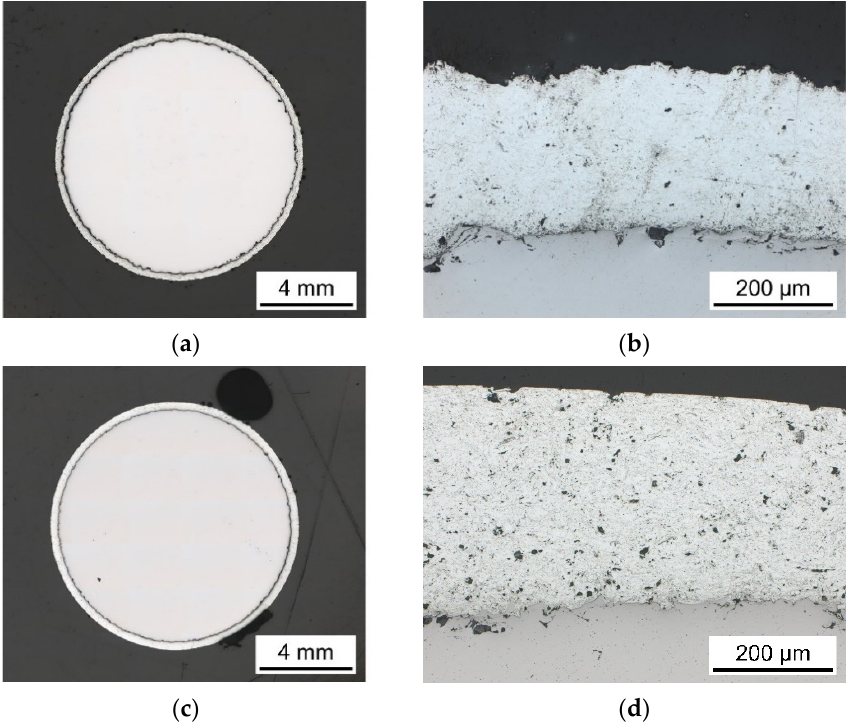
Figure 8. Images of coating systems, ( a ) overview of ZnAl-coated (II) specimen, ( b ) ZnAl-coating (II), ( c ) overview of machine hammer-peened (III) specimen, ( d ) machine hammer-peened (III) ZnAl-coating. Light microscopic images were taken at three locations to determine the coating thick- ness. Table 2 shows the coating thickness as average, including the standard deviation of three measurements at three locations. After MHP post-treatment (III), standard deviations